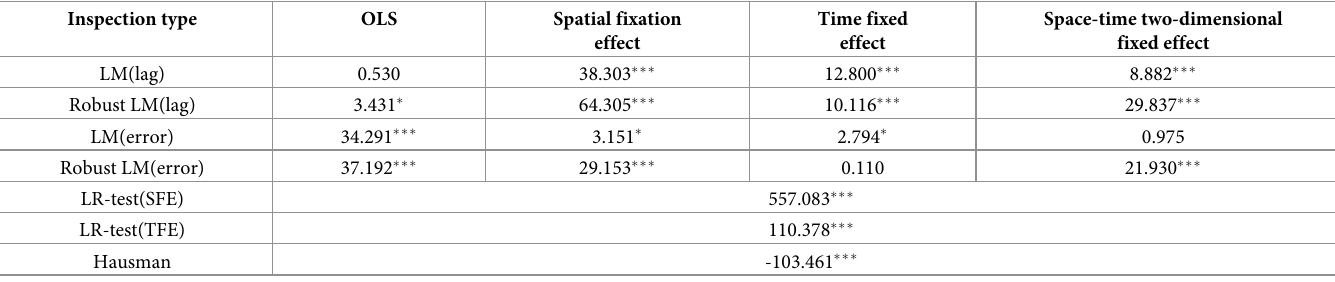
Table 4. LM, LR and Hausman test of high-quality economic development